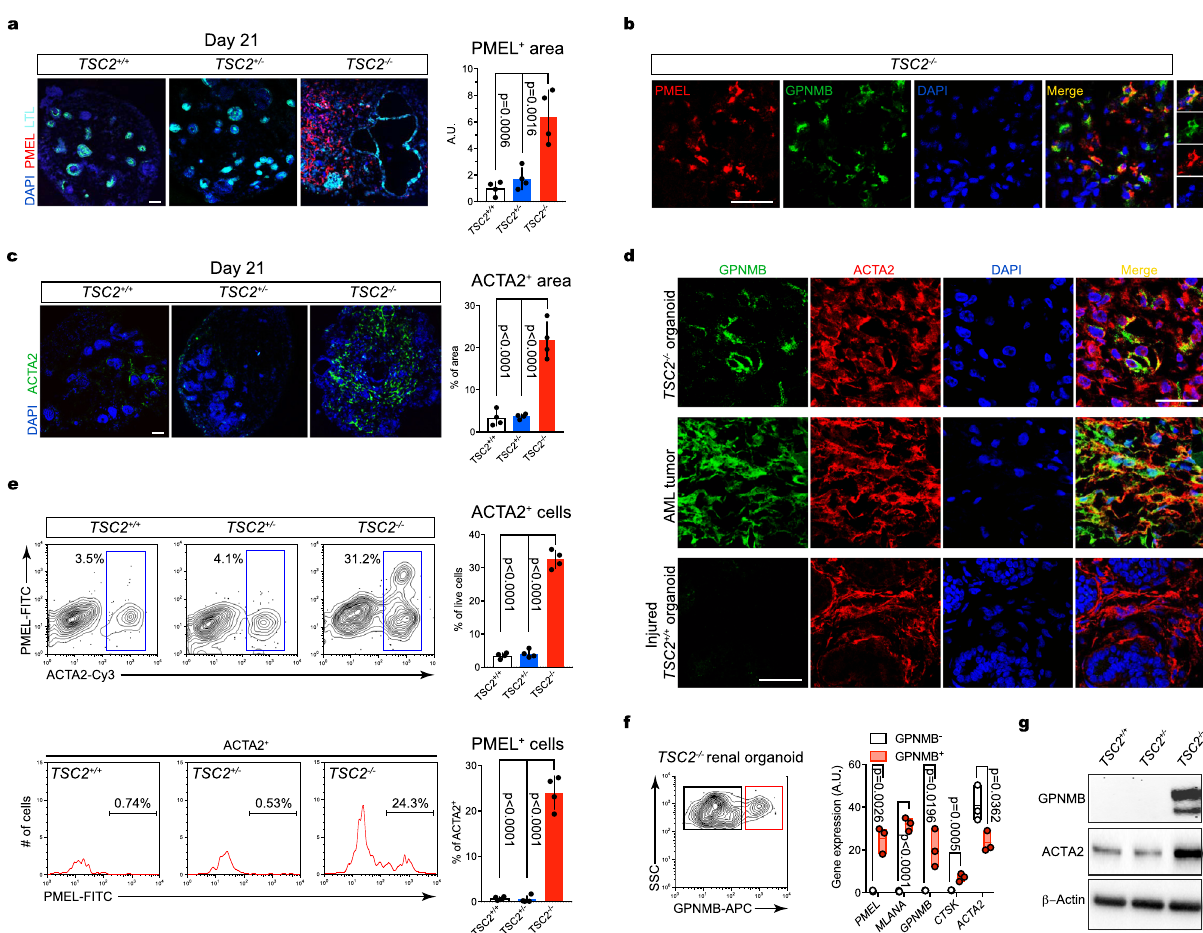
Fig. 2 TSC2 − / − renal organoids recapitulate human AML tumor phenotype. a – c Confocal optical sections showing LTL with PMEL ( a ), PMEL and GPNMB ( b ), and ACTA2 ( c ) in Day 21 3D renal organoids derived from TSC2 + / + , TSC2 − / − and TSC2 + / − hiPSCs. Bar graphs in ( a ) and ( c ) represent mean ± SD, n = 4 experiments. P values for individual comparisons done using Tukey test in one-way ANOVA analysis are indicated. d Representative confocal immuno fl uorescence sections showing expression of GPNMB and ACTA2 in Day-21 TSC2 − / − renal organoids, kidney AML tumor and fi brotic Day-28 TSC + / + renal organoids injured by incubation with interleukin 1 β for 96 h. e Representative FACs plots and quanti fi cation showing the percentage of ACTA2 + cells and PMEL + cells in Day-21 TSC2 + / + , TSC2 − / − and TSC2 + / − renal organoids. Bar graphs represent mean ± SD, n = 4 experiments. P values for individual comparisons done using Tukey test in one-way ANOVA analysis are indicated. f Representative cell sorting plot showing the GPNMB + (red square) and GPNMB - (black square) cell fractions in TSC2 − / − renal organoids and gene expression levels for PMEL , MLANA , GPNMB , CTSK , and ACTA2 , determined by Quantitative RT-PCR analysis. Floating bars graph represent mean ± SD, n = 3 independent experiments, containing three organoids each. P values for individual comparisons done using two-tailed Student ’ s t test are indicated. g Representative immunoblot showing expression of GPNMB and ACTA2 in renal organoids from the three genotypes. Two independent experiments were performed with similar results. Scale bars, 50 μ transcriptome RNA-seq datasets, comparing TSC2 − / − organoids to TSC2 + / + and TSC2 + / − organoids, using Qlucore software. Several hundred genes were upregulated or downregulated at a false dis- covery rate (FDR)/ q value < 0.05, p value < 0.002, |log 2 fold | > 2 and |log 2 fold change | <-2 (Supplementary Table 1). Among the genes upregulated in the TSC2 − / − organoids were: MLANA, PMEL,